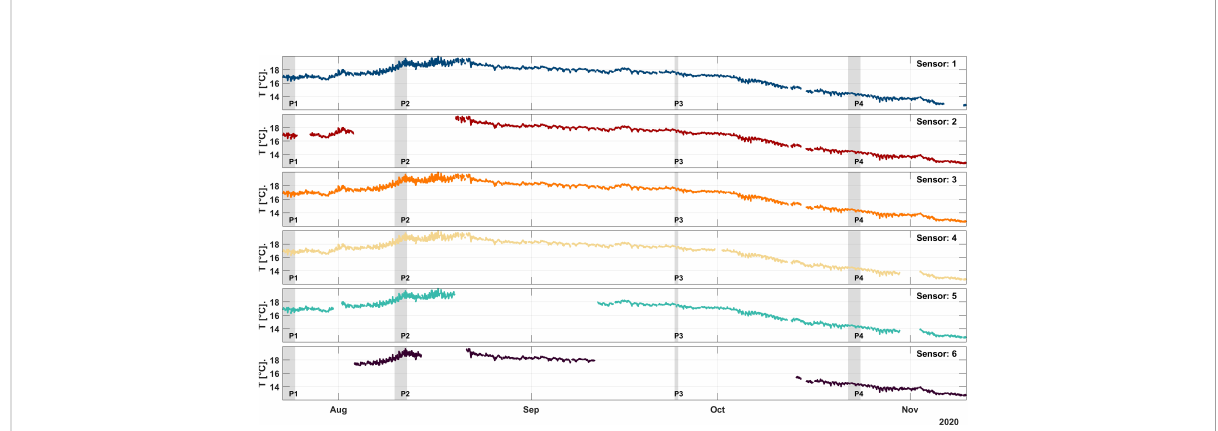
FIGURE 3 Measured temperature data of the six sensors for the whole measurement period (June 22 – Nov 10). Grey shaded areas indicate selected analysis periods. Unlabeled data gaps are due to different download speeds or caused by telemetry interruption.